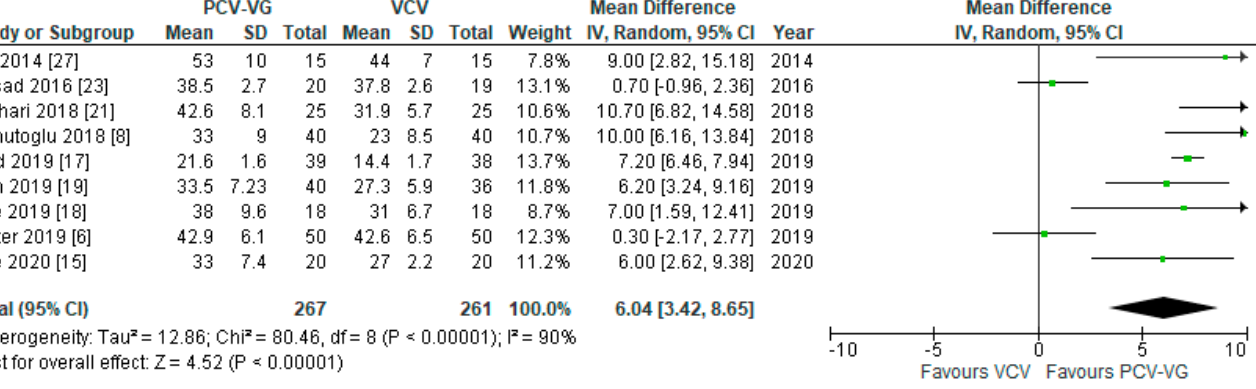
Figure 7. Dynamic compliance (C dyn ): supine, two-lung ventilation. The green center of each square represents the weighted mean difference for individual trials, and the corresponding horizontal line stands for a 95% confidence interval. The diamonds represent pooled results.